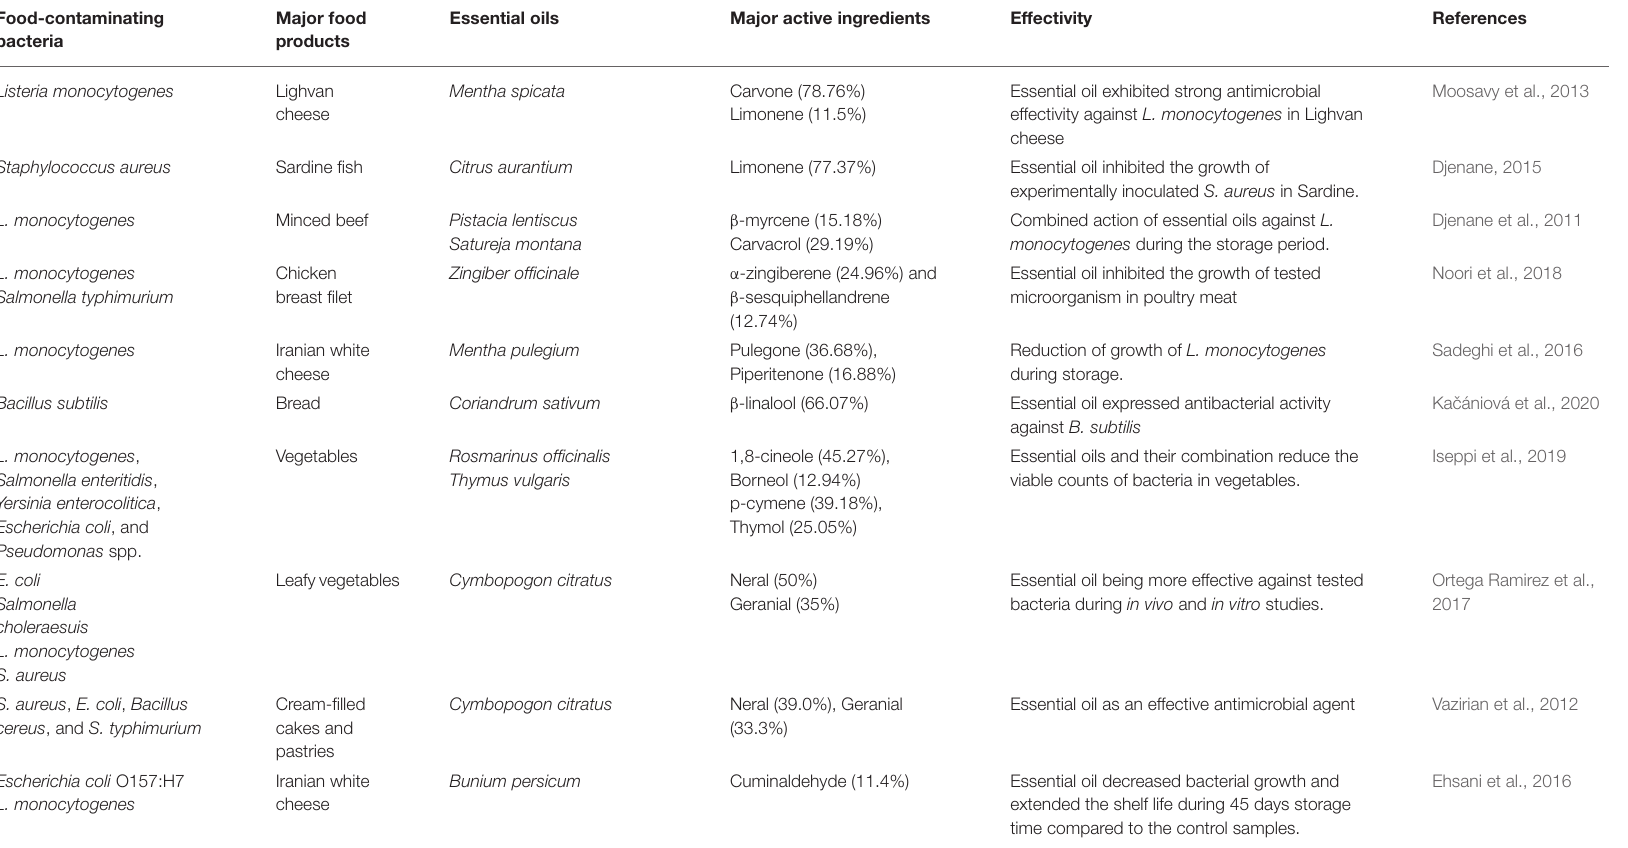
TABLE 2 | Essential oils and their active components against different food contaminating